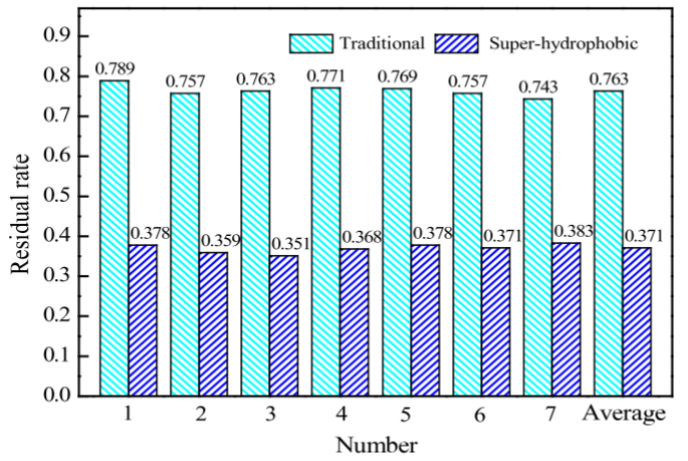
Figure 6. Residual ice formation rate under hail conditions. Reprinted with permission from [49].